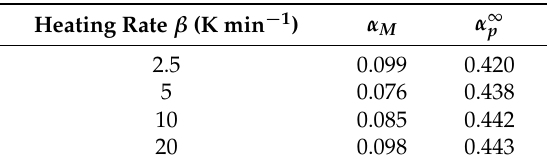
Table 4. Maximum values of the calculated y ( α ) and z ( α ) functions corresponding to the crosslinking of a partially bio-based epoxy resin for different heating